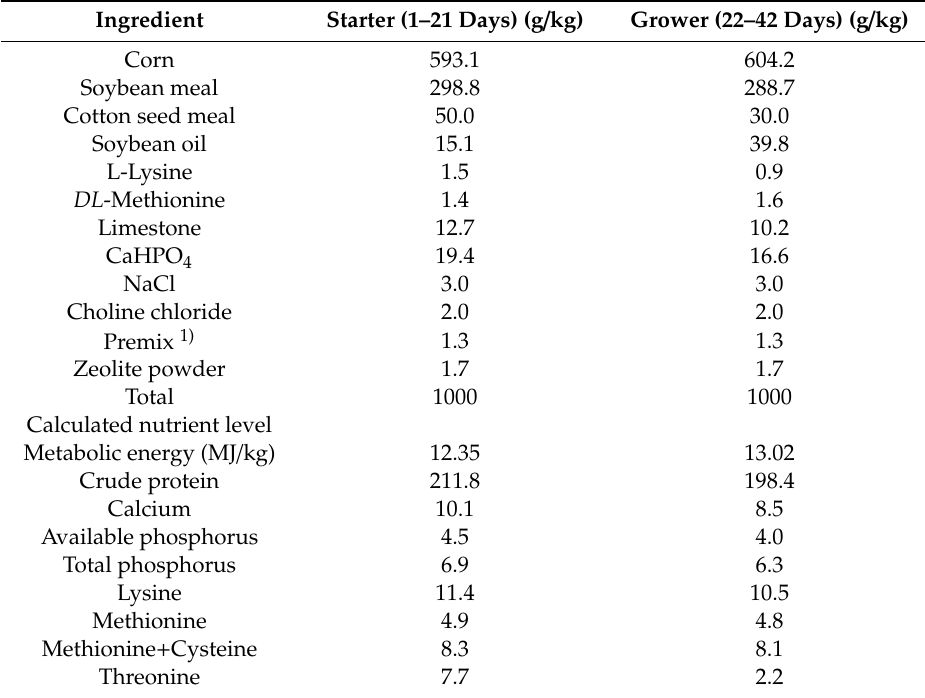
Table 1. Ingredient and nutrient composition of basal broiler